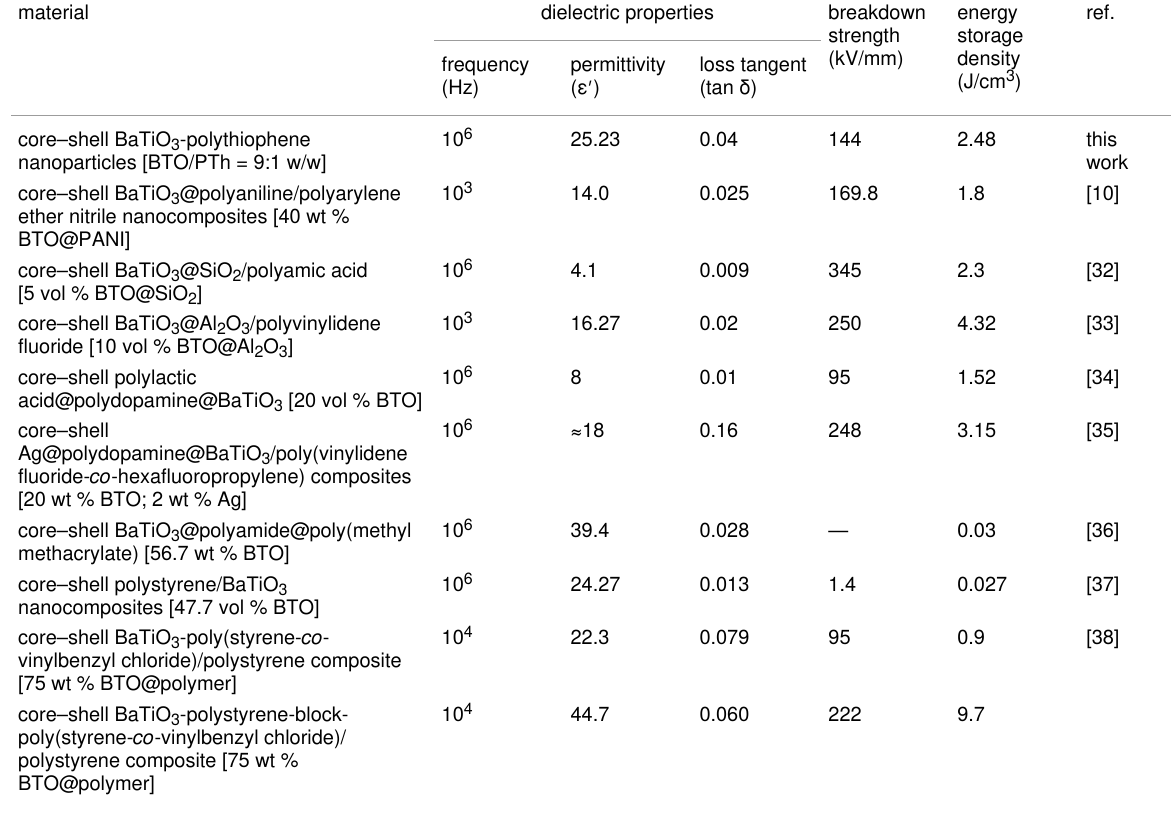
Table 1: A comparison of the electrical properties of core–shell BTO-PTh nanoparticles with other BTO-polymer composite dielectric materials re- ported in literature.